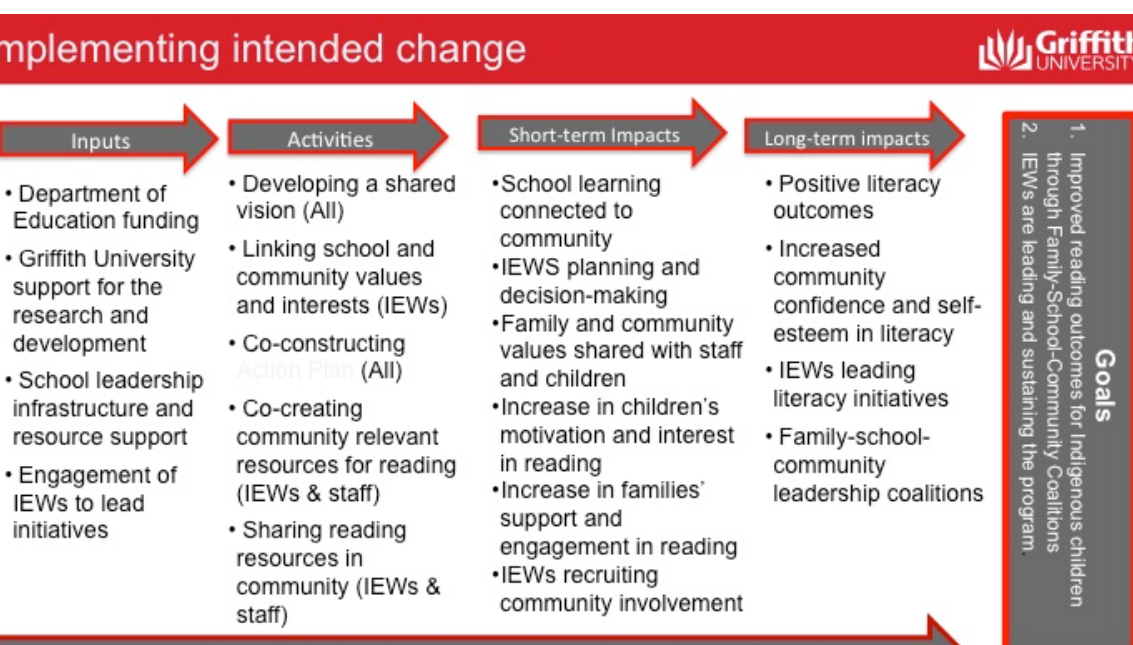
Figure 4. A theory of